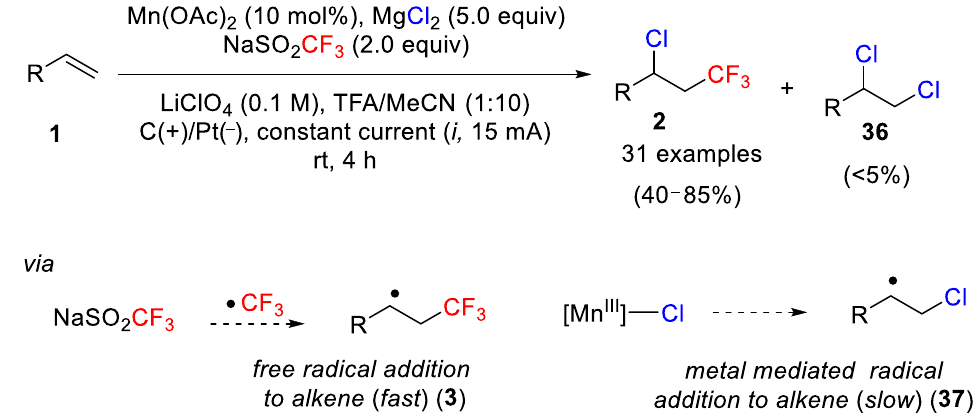
Scheme 27. Heterodifunctionalization of alkenes by anodic coupled electrolysis.